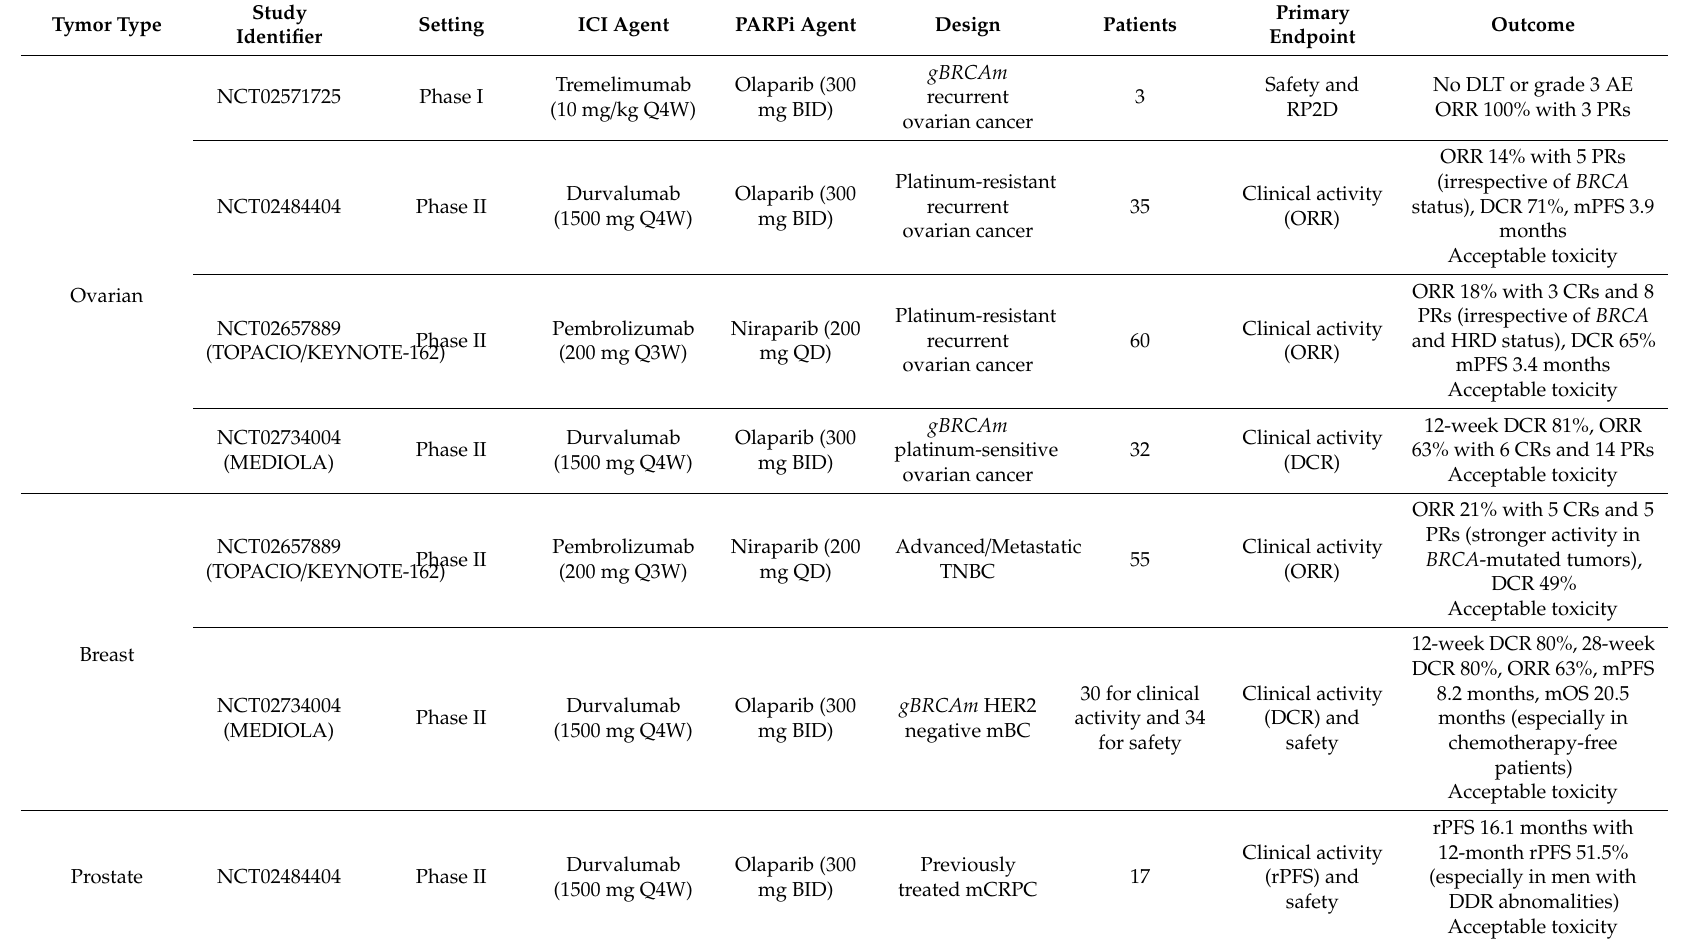
Table 1. Recent clinical trials of combination of PARPi and